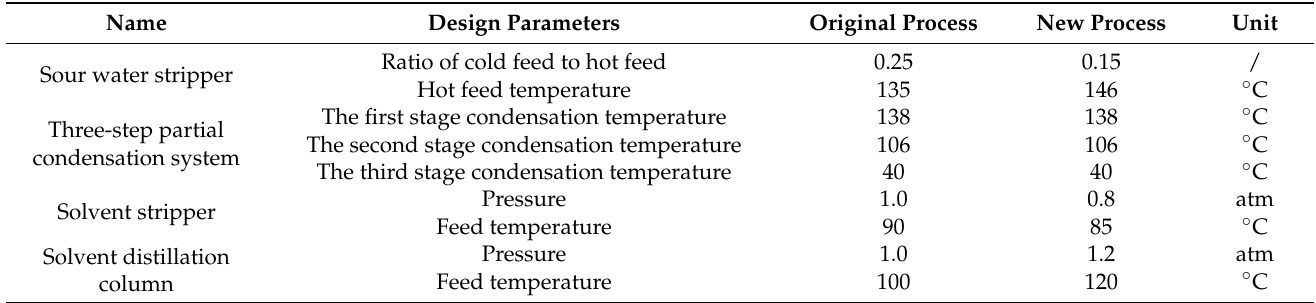
Table 6. Optimal parameters at the lowest total annual cost.